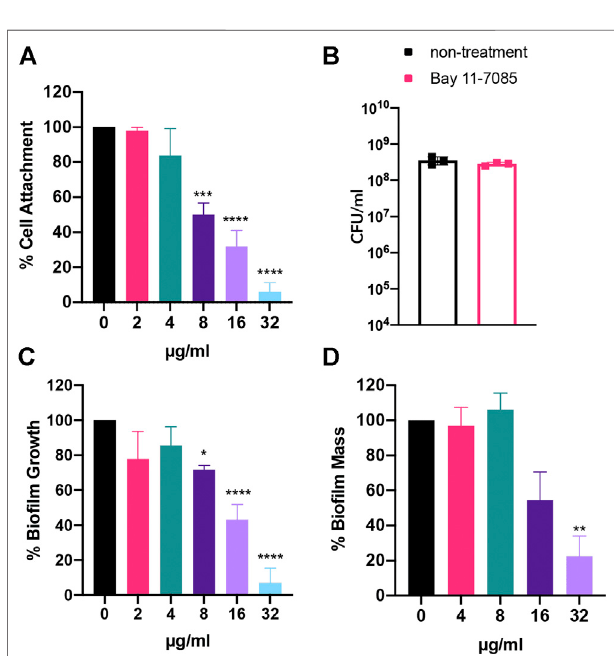
FIGURE 4 | Bay11-7085showsanti-bio fi lmactivitytowardthreephasesof S. aureus strain VRS1 bio fi lm maturation. Ef fi cacity of Bay 11-7085 at various concentrations were tested against S. aureus strain VRS1 bio fi lm (A) initial cell attachment. (B) CFU/ml was measured of treated and untreated conditions afterinitialcellattachmentassay. S.aureus strainVRS1bio fi lm (C) inhibitionand (D) eradication was measured using 1% crystal violet. X-axis represents concentrations of Bay 11-7085 in µg/ml. Statistical signi fi cance was determined using one-way ANOVA with Dunnett ’ s test for multiple comparisons. * p < 0.05; ** p < 0.01; *** p < 0.001; **** p < 0.0001. ( n (cid:2) 3, ±